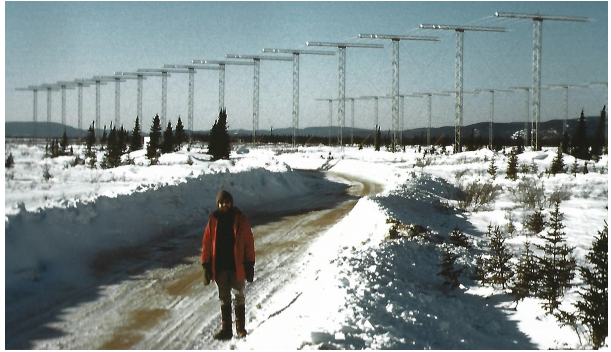
Figure 5. Photograph taken in 1988, showing the main array of the Goose Bay radar, the 16-antenna interferometer array, and John Du- deney. John is standing about halfway between the center of the main array and the white building that was identified in Fig. 1.